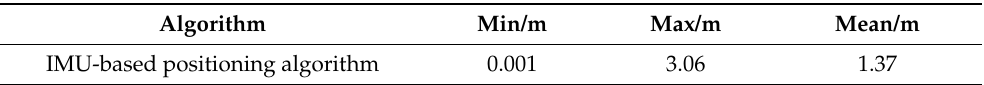
Table 3. Comparisons of errors of three algorithms.